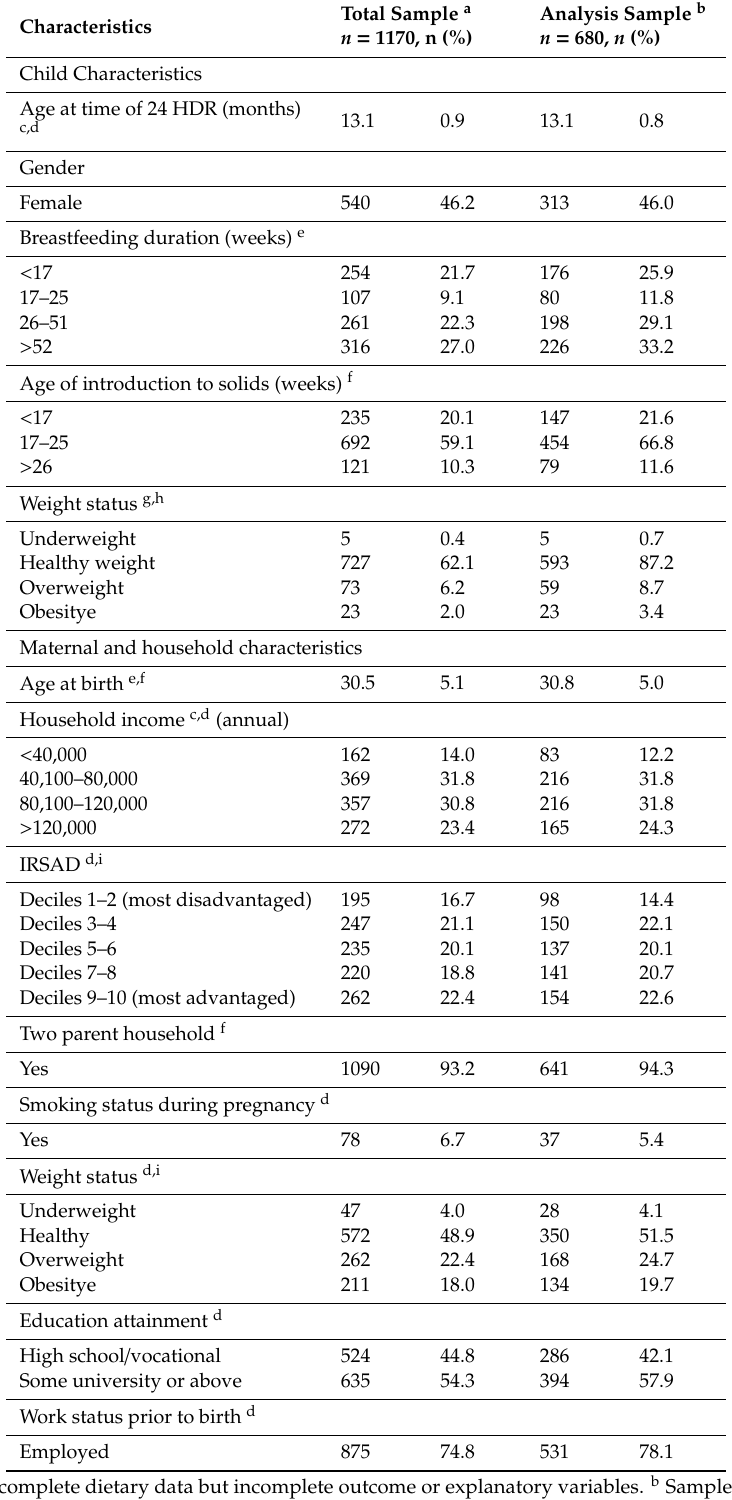
Table 1. Characteristics of mother-child dyads in the sample with complete dietary data and sample with complete outcome and explanatory